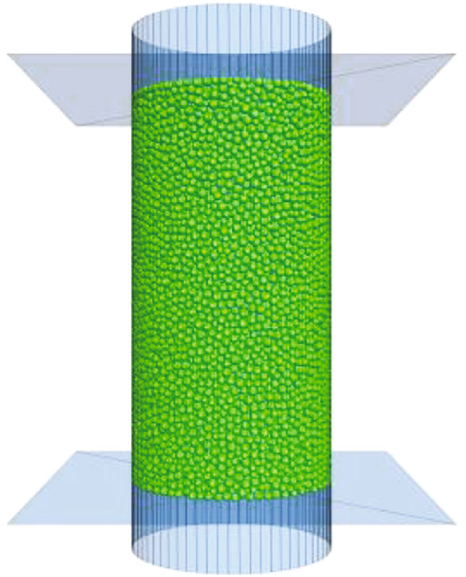
Figure 5: The PFC 3D model of standard triaxial compression